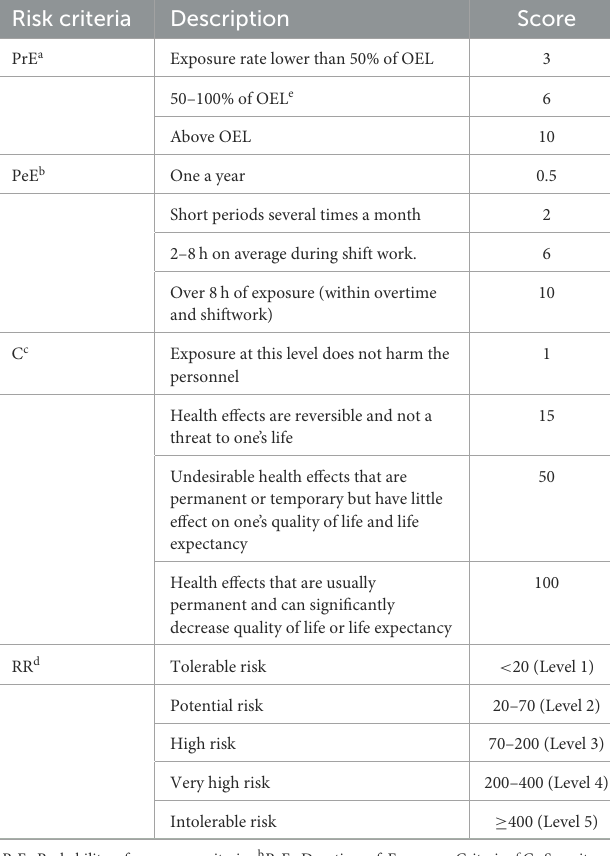
TABLE 1 Risk scoring table for risk